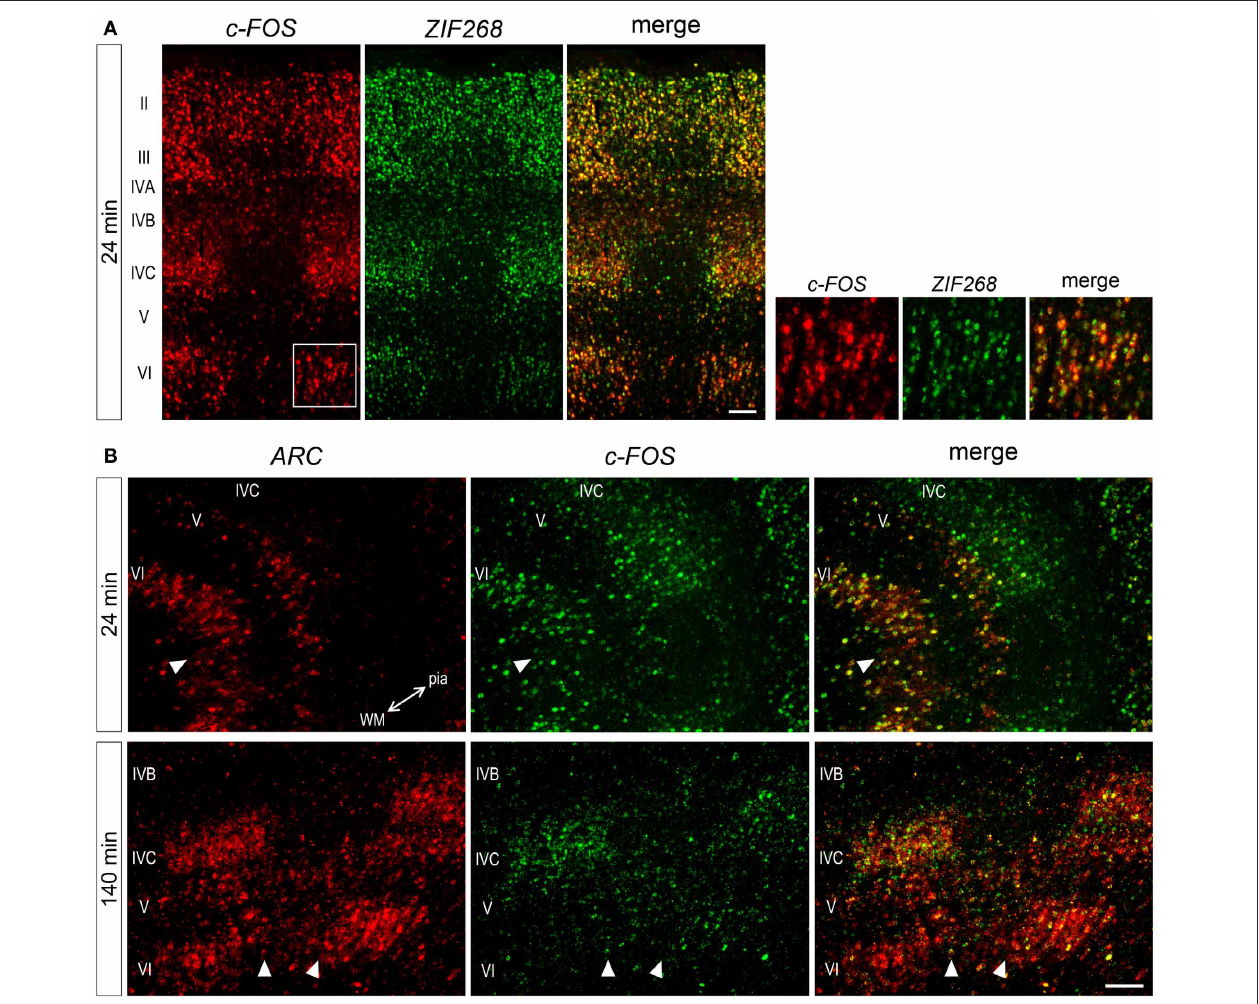
in V1. ARC and c-FOS mRNAs were coexpressed in most neurons in the layers when they were expressed at each time point. The two-way arrow indicates the direction of lamination from pial (pia) to white matters (WM). Arrowheads indicate the boundaries of ODCs. Scale bars: 100 μ